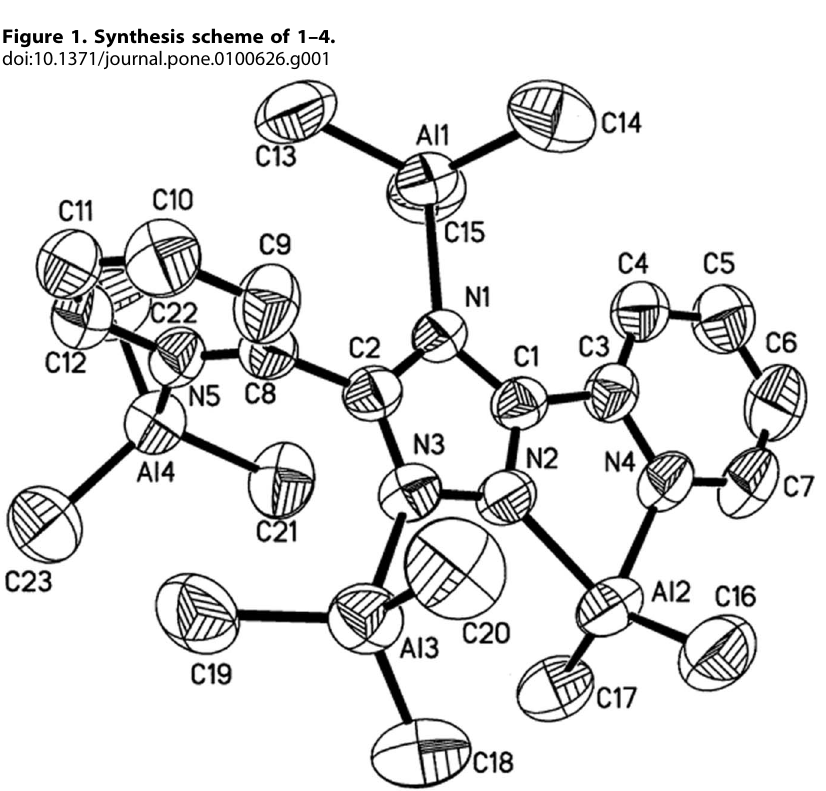
Figure 2. Molecular structure of 1 (50% probability thermal ellipsoids). doi:10.1371/journal.pone.0100626.g002 PLOS ONE |